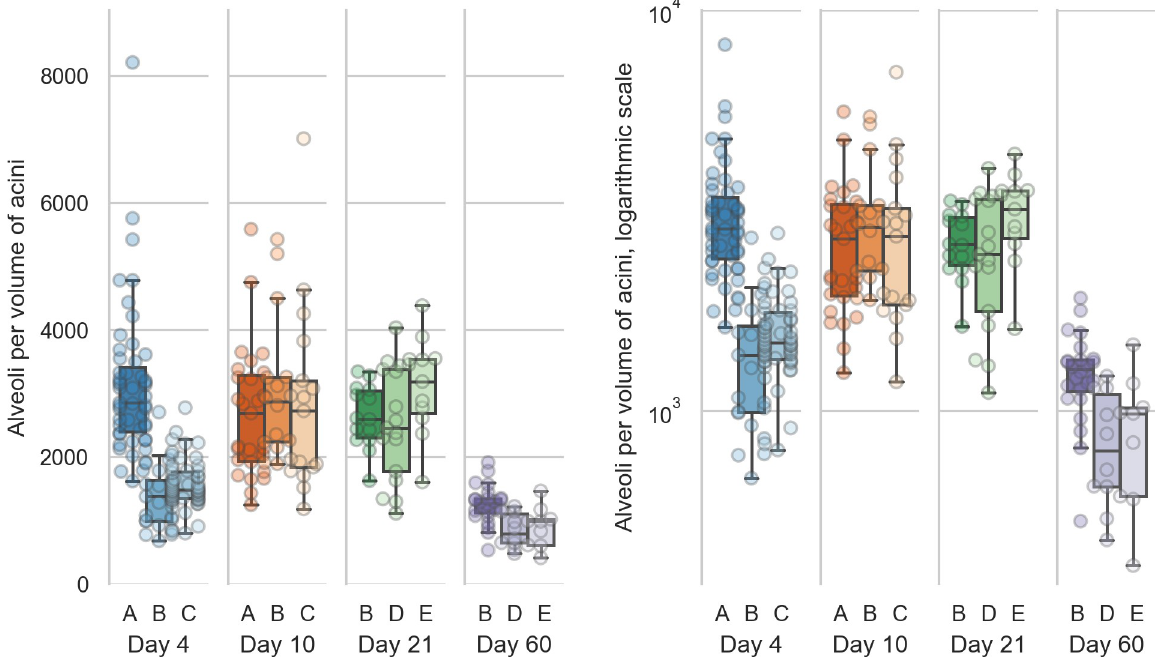
Fig 5. Number of alveoli per acinus volume. Left: linear scale, right: logarithmic scale. The number of alveoli per acinus volume are all significantly different (all p-values are smaller than 5e-5, which is the p-value between days 4 and 21) for each combination of days except between days 10 and 21 (p =